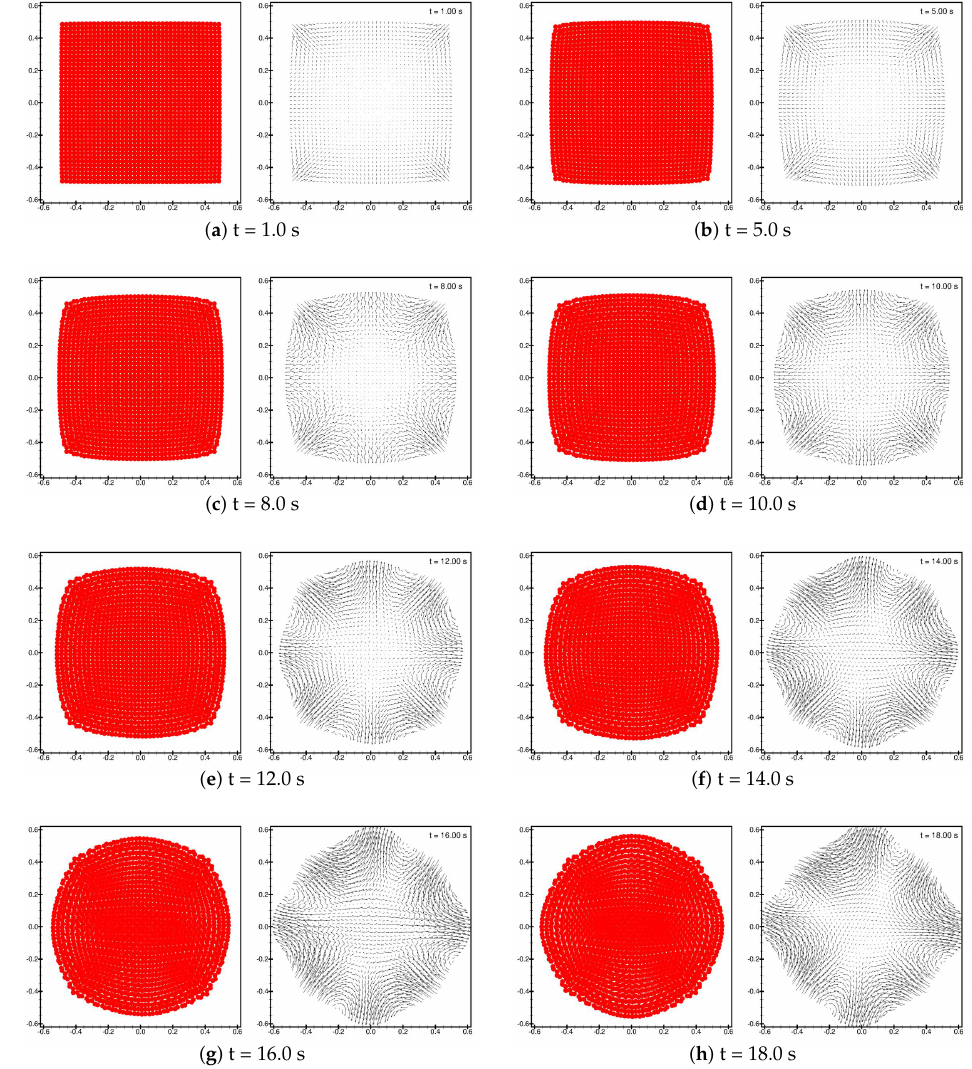
Figure 3. The evolution of particle position and velocity for a single-phase square bubble. The coordinate axes are x in horizontal and y in vertical directions, and the same hereafter if not